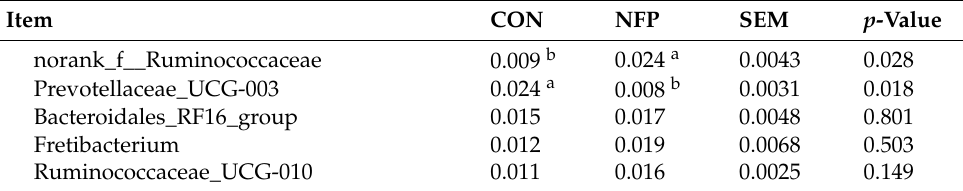
a,b Without a common superscript letter indicates significant ( p < 0.05) changes between treatments. Abbreviations: Figure 4. Statistical analysis of different bacterial taxa at the phylum level by Student’s t ‐ test in Exp. 2 CON, control treatment; NFP, treatment with NFP supplementation with 4 g/kg DM (0.40% NFP); SEM, standard (* 0.01 < p ≤ 0.05, ** 0.001 < p ≤ 0.01, *** p ≤ 0.001). error of mean.